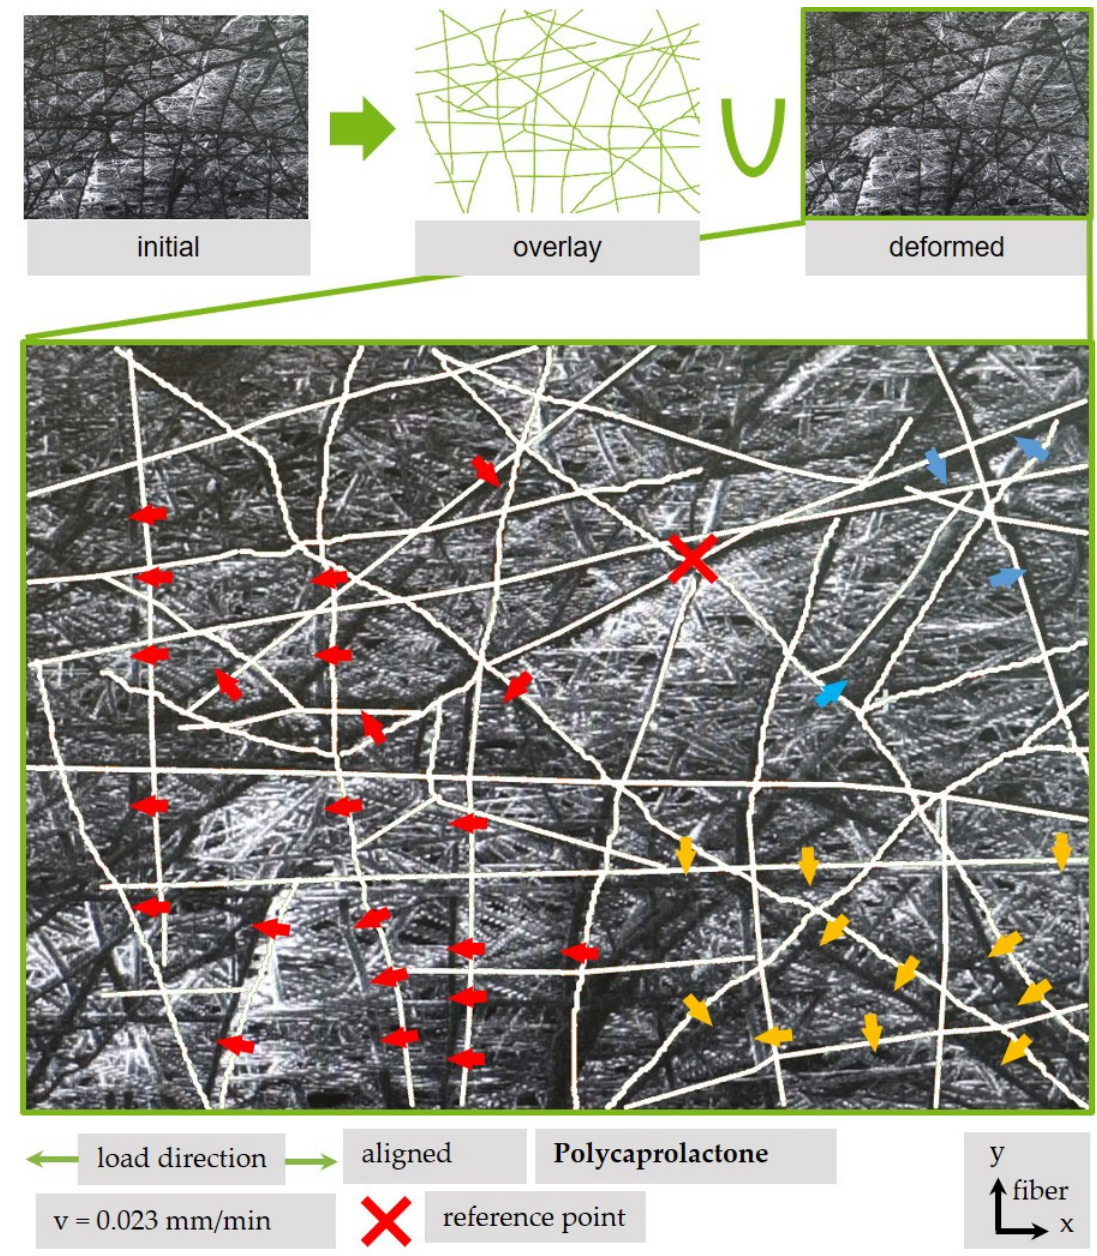
Figure 11. Indicators and schematic overlay for the movement of aligned PCL fibers under tensile load.